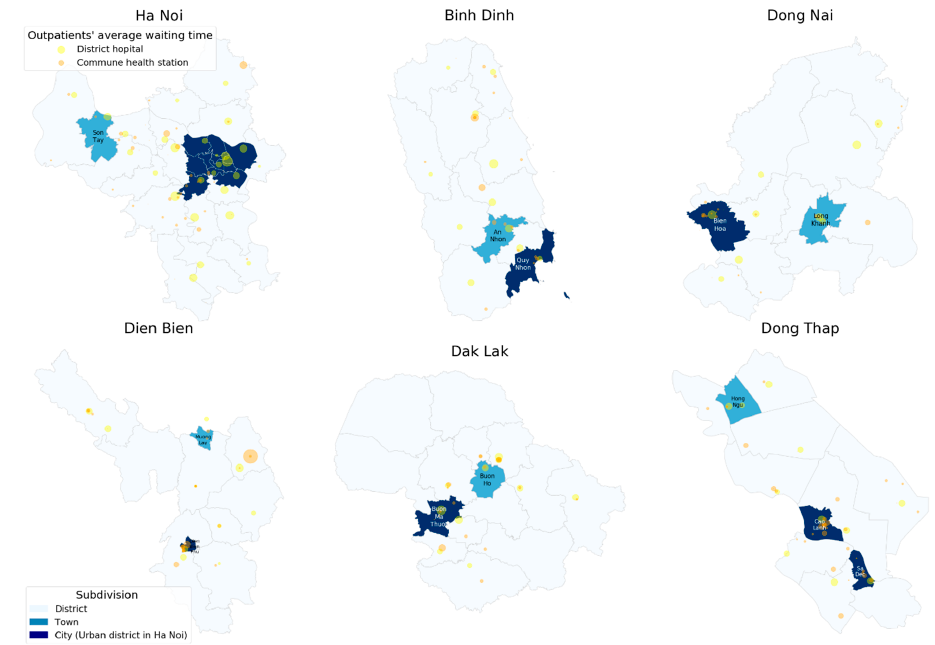
Figure 3. A dot distribution map of average outpatient waiting times at commune health stations and district hospitals in each province according to commune health stations and district hospitals.